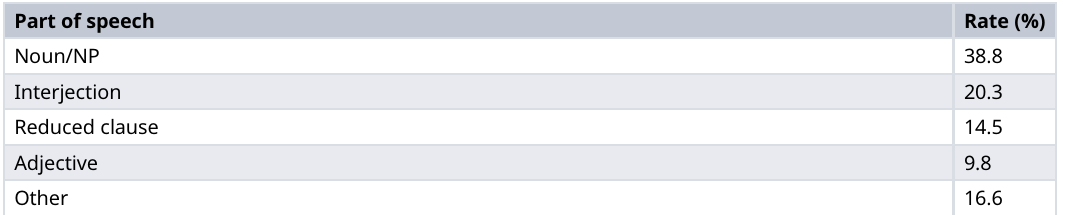
Table 2. Grammatical categories in the X-slot (based on Bohmann 2016: